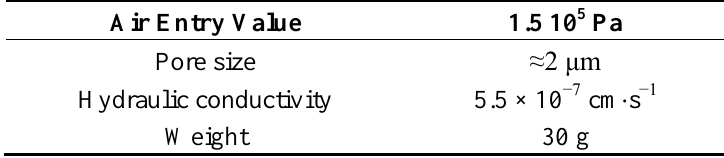
Figure 3. Scheme of the porous SDEC 2150 ceramic cup